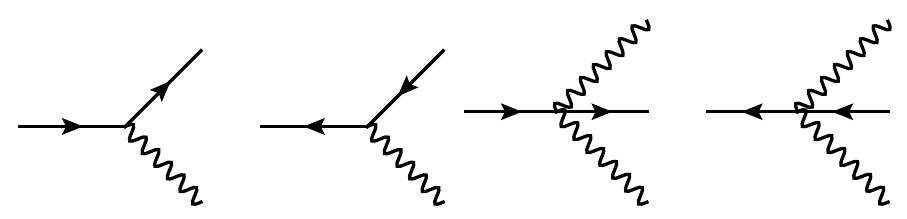
Figure 9 . The interaction vertices for emission of one or two photons from positively and negatively charged wino lines.